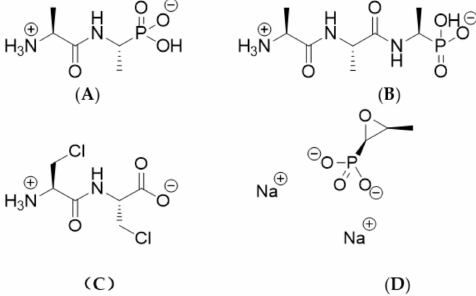
Figure 1. Structures of four compounds used in this study. Systematic names (and abbreviations used in this study) are as